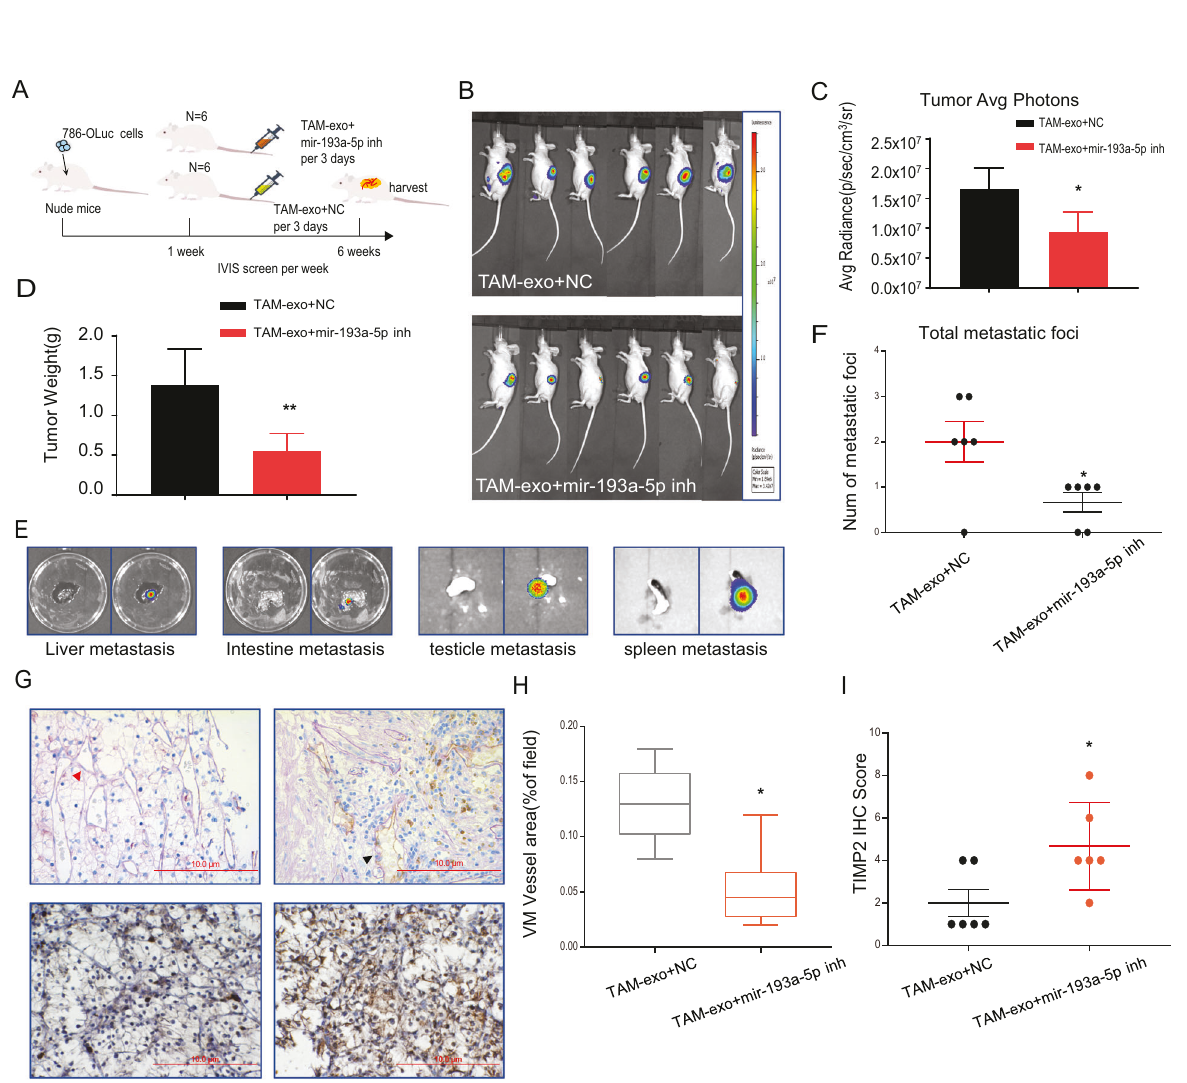
Fig. 6 Preclinical study using an in vivo mouse model revealed that inhibition of miR-193a-5p in MDEs represses tumor progression and metastasis. A A sketch map of tumor formation in nude mice. Macrophages were transfected with NC miRNA inhibitor or miR-193a-5p inhibitor, after which exosomes were extracted and injected into nude mice ( N = 6). B IVIS images of mice harboring RCC tumors after orthotopic implantation of 786-O cells for 6 weeks. C Tumor average photons for ccRCC from xenograft mice. D Tumor volume in each group was observed and measured after mice were sacri fi ced. E Representative organ bioluminescent images showing metastasis from the liver, intestine, testicle, and spleen. F Quanti fi cation of the total metastatic foci. G Representative images of IHC staining for TIMP2 and VM vessel area (red triangles show PAS + /CD31 − tumor cell-dependent vessels) in mice. H Evaluation of area percentage of VM vessels. I Quanti fi cation of the relative IHC staining intensity for TIMP2 expression. The data are shown as the mean ± SD. * p < 0.05, ** p < 0.01, *** p < 0.001, and ns no signi fi cance compared with the